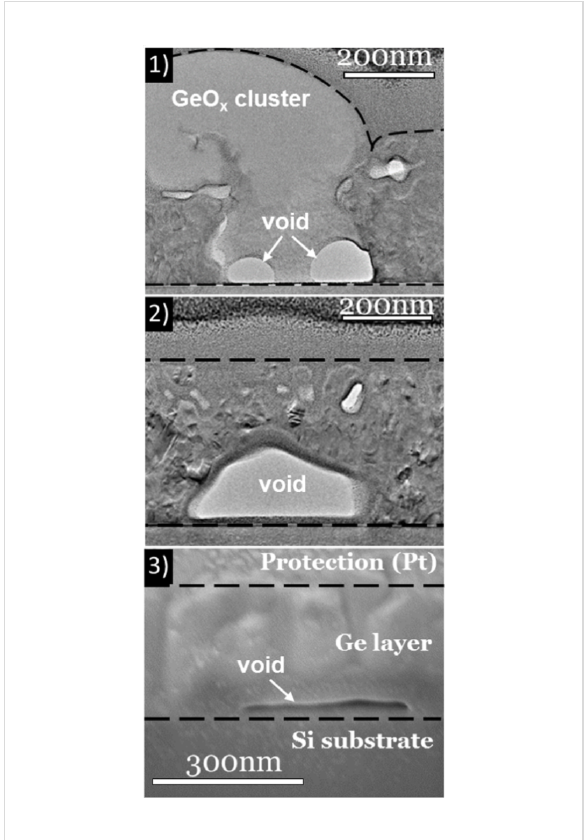
Figure 4: (1) and (2) TEM cross-sectional view of the Se-implanted sample after annealing with TB = 3.1 µm. (3) SEM cross-sectional view of the Se-implanted sample after annealing with TB = 4.8 µm.